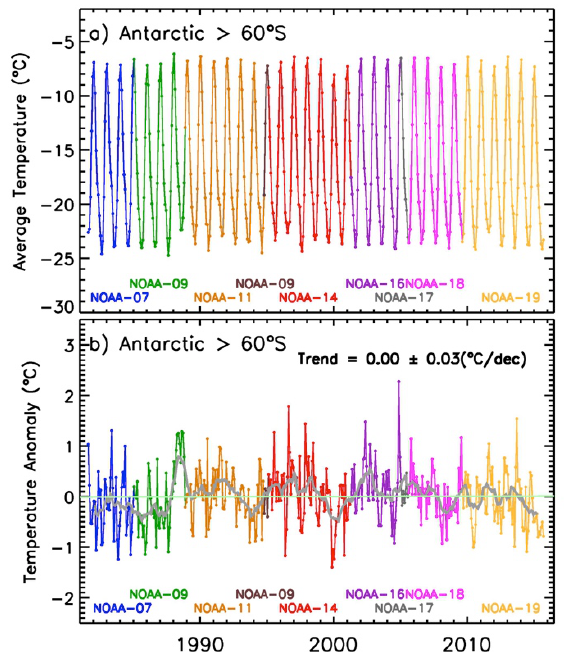
Figure 4. (a) Monthly averages and (b) monthly anomalies of surface temperature in the Antarctic for the region >